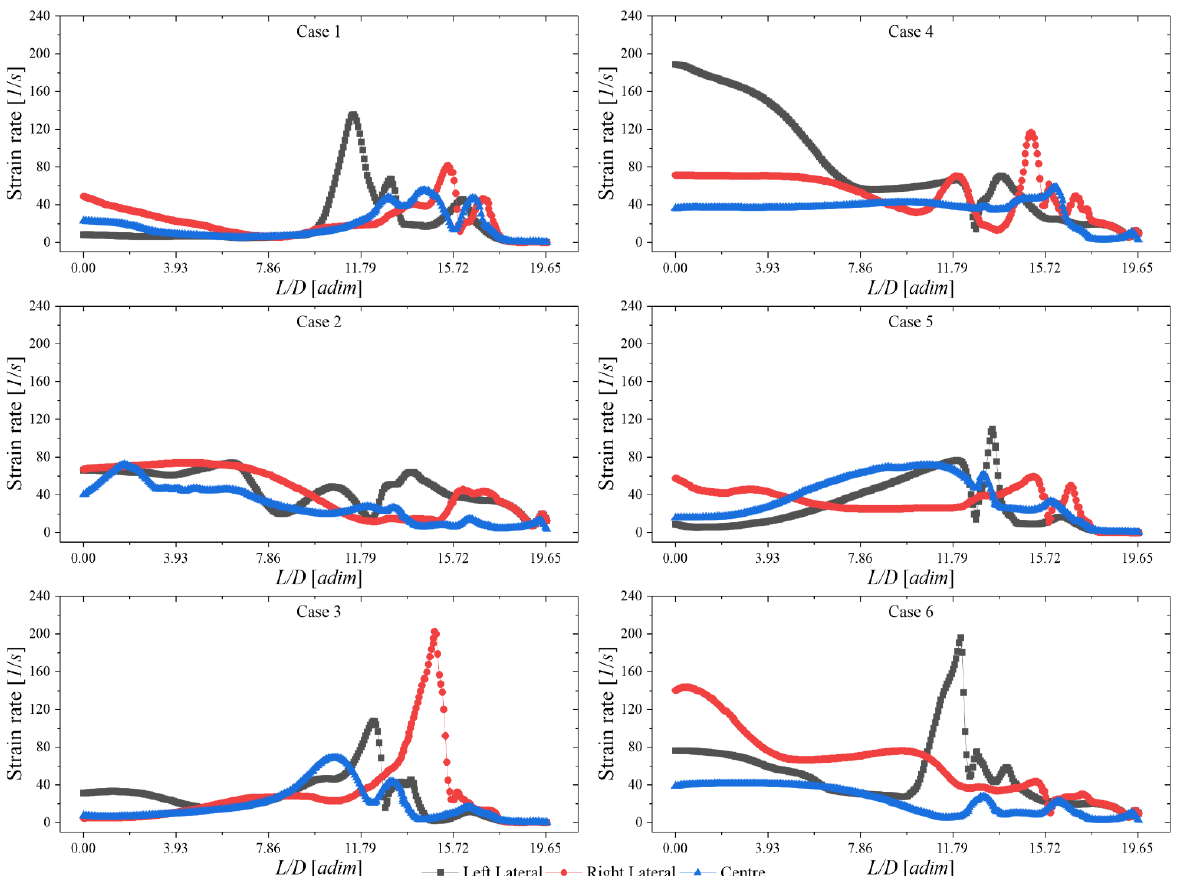
Figure 5. Strain rate values over the three different markers of the distinct cases.